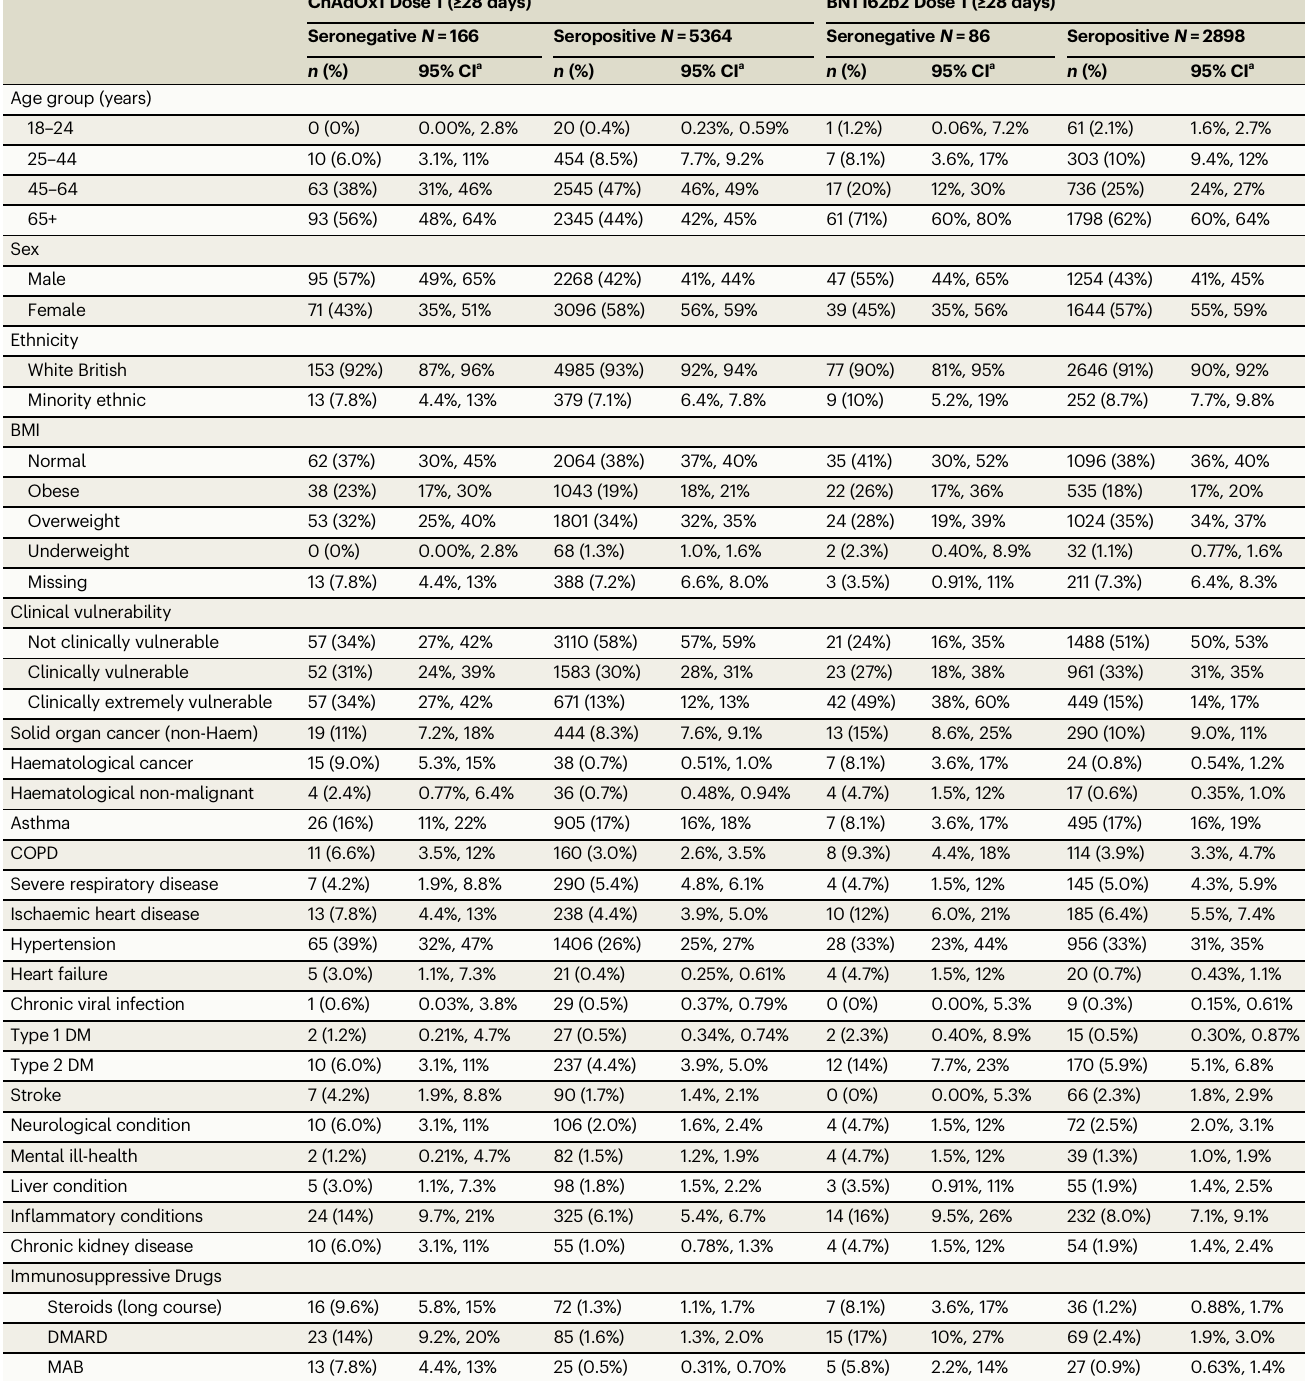
Table 2 | Demographic and clinical characteristics of individuals who were seronegativeand individuals who were seropositive (as per the ≥ 0.8 U/ml cut-off for Spike-antibody level) at ≥ 28 days after receiving Dose 1, with percentage estimates and 95% con fi dence intervals for seropositivity and seronegativity